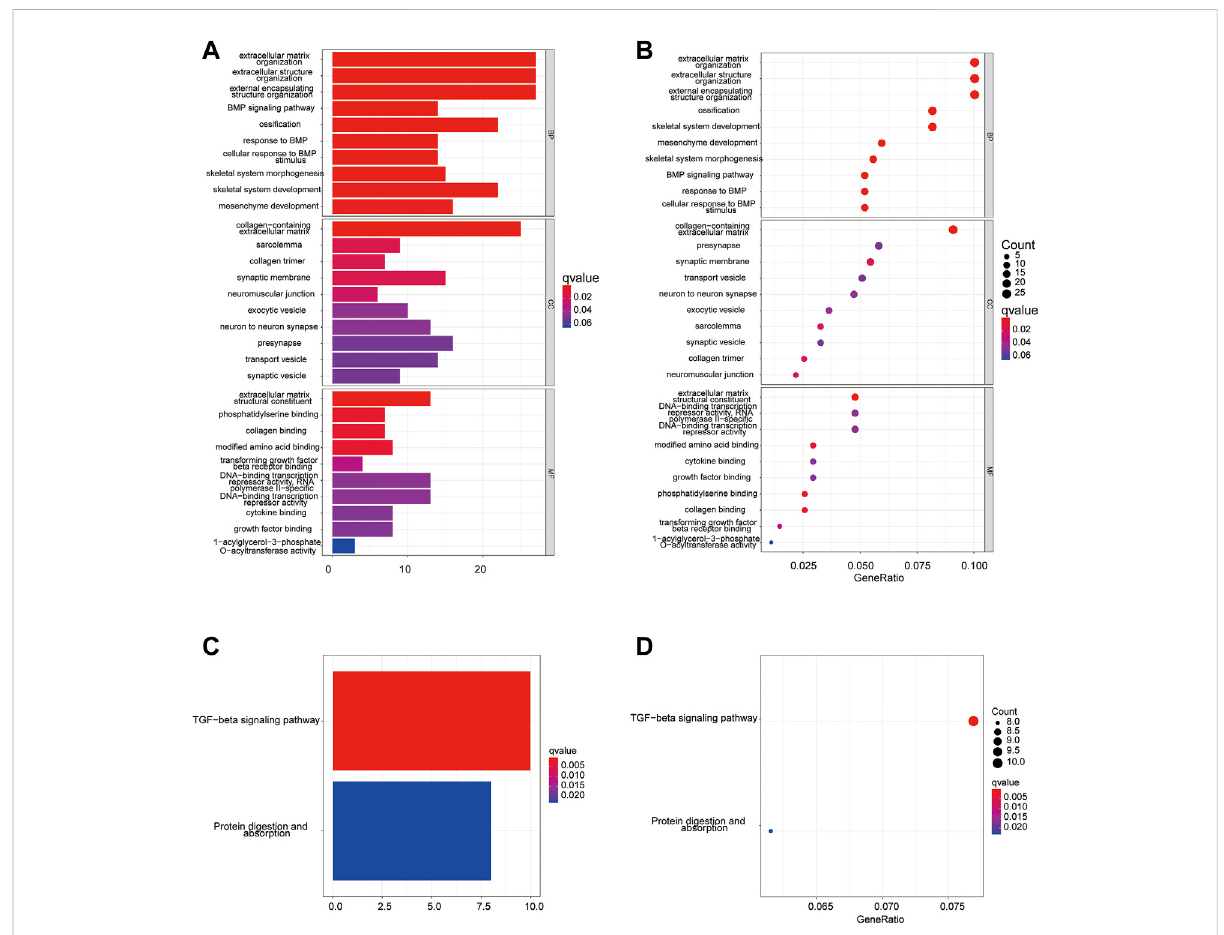
FIGURE 11 Functional analysisoftraining cohort(from TARGET dataset). (A,C) Barplotgraph forGO (A) and KEGG (C) pathways; (B,D) Bubble graph forGO (B) and KEGG (D)